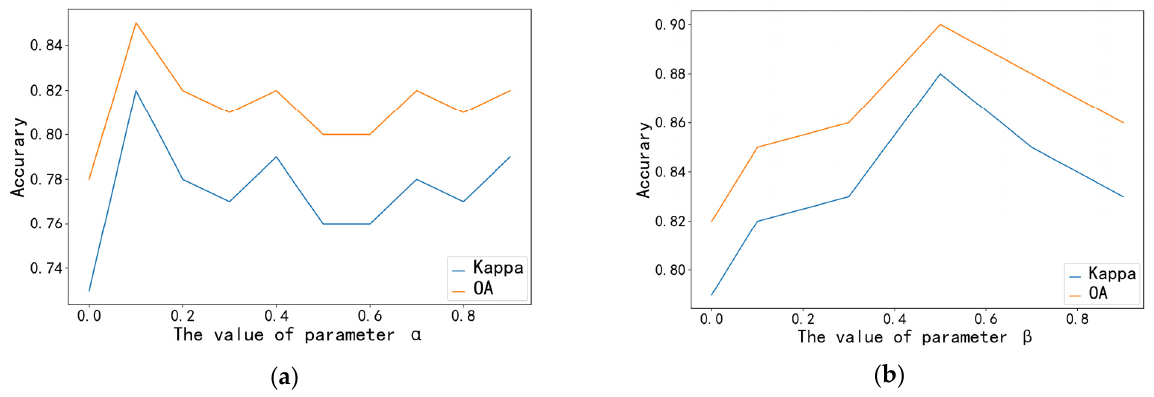
Figure 9. Influence of the parameters on the overall accuracy and the kappa value: ( a ) parameter 𝛼 ; ( b ) parameter 𝛽 . ( b ) parameter β